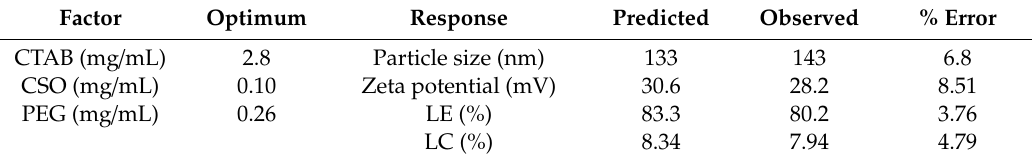
Table6. Optimalcalculatedvariables, andtheobserved, predicted, andresidualvaluesfortheresponses. Factor Optimum Response Predicted Observed % Error CTAB (mg / mL) 2.8 Particle size (nm) 133 143 6.8 CSO (mg / mL) 0.10 Zeta potential (mV) 30.6 28.2 8.51 PEG (mg / mL) 0.26 LE (%) 83.3 80.2 3.76 LC (%) 8.34 7.94 4.79 Criterion for optimization = minimum particle size, ≥ ± 20 mV of zeta potential, maximum LE and LCDesirability value =